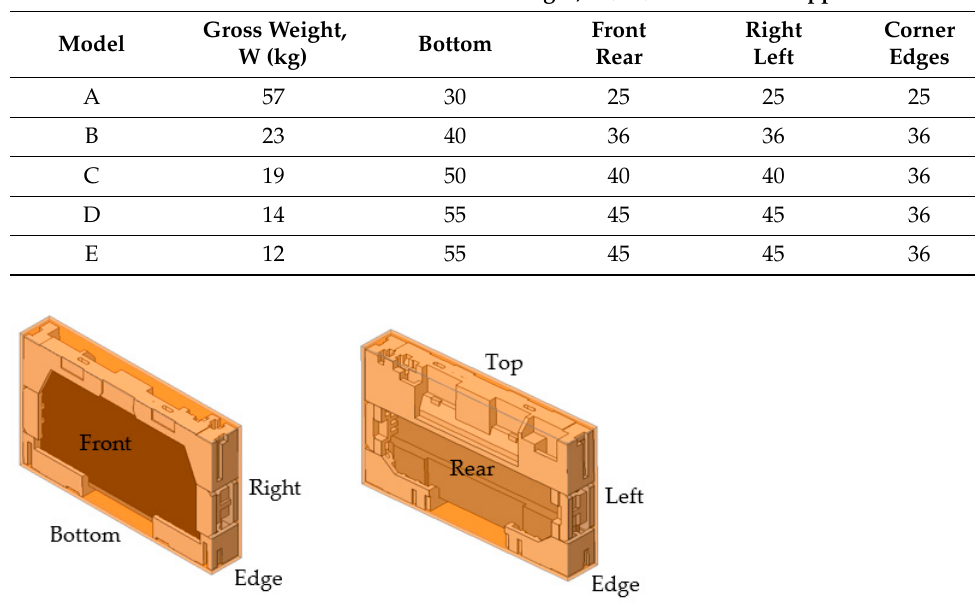
Table 2. Drop-test height.